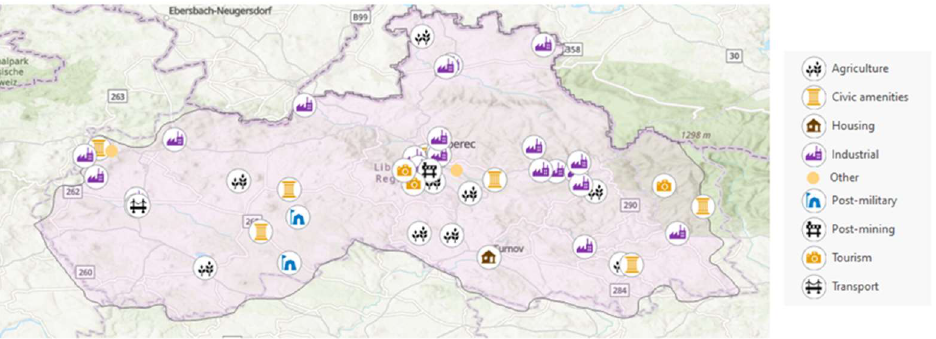
Figure 3. Map of brownfields in the Liberec Region, own creation based on mapping with geographic information tools (ArcGIS) using data from [41].